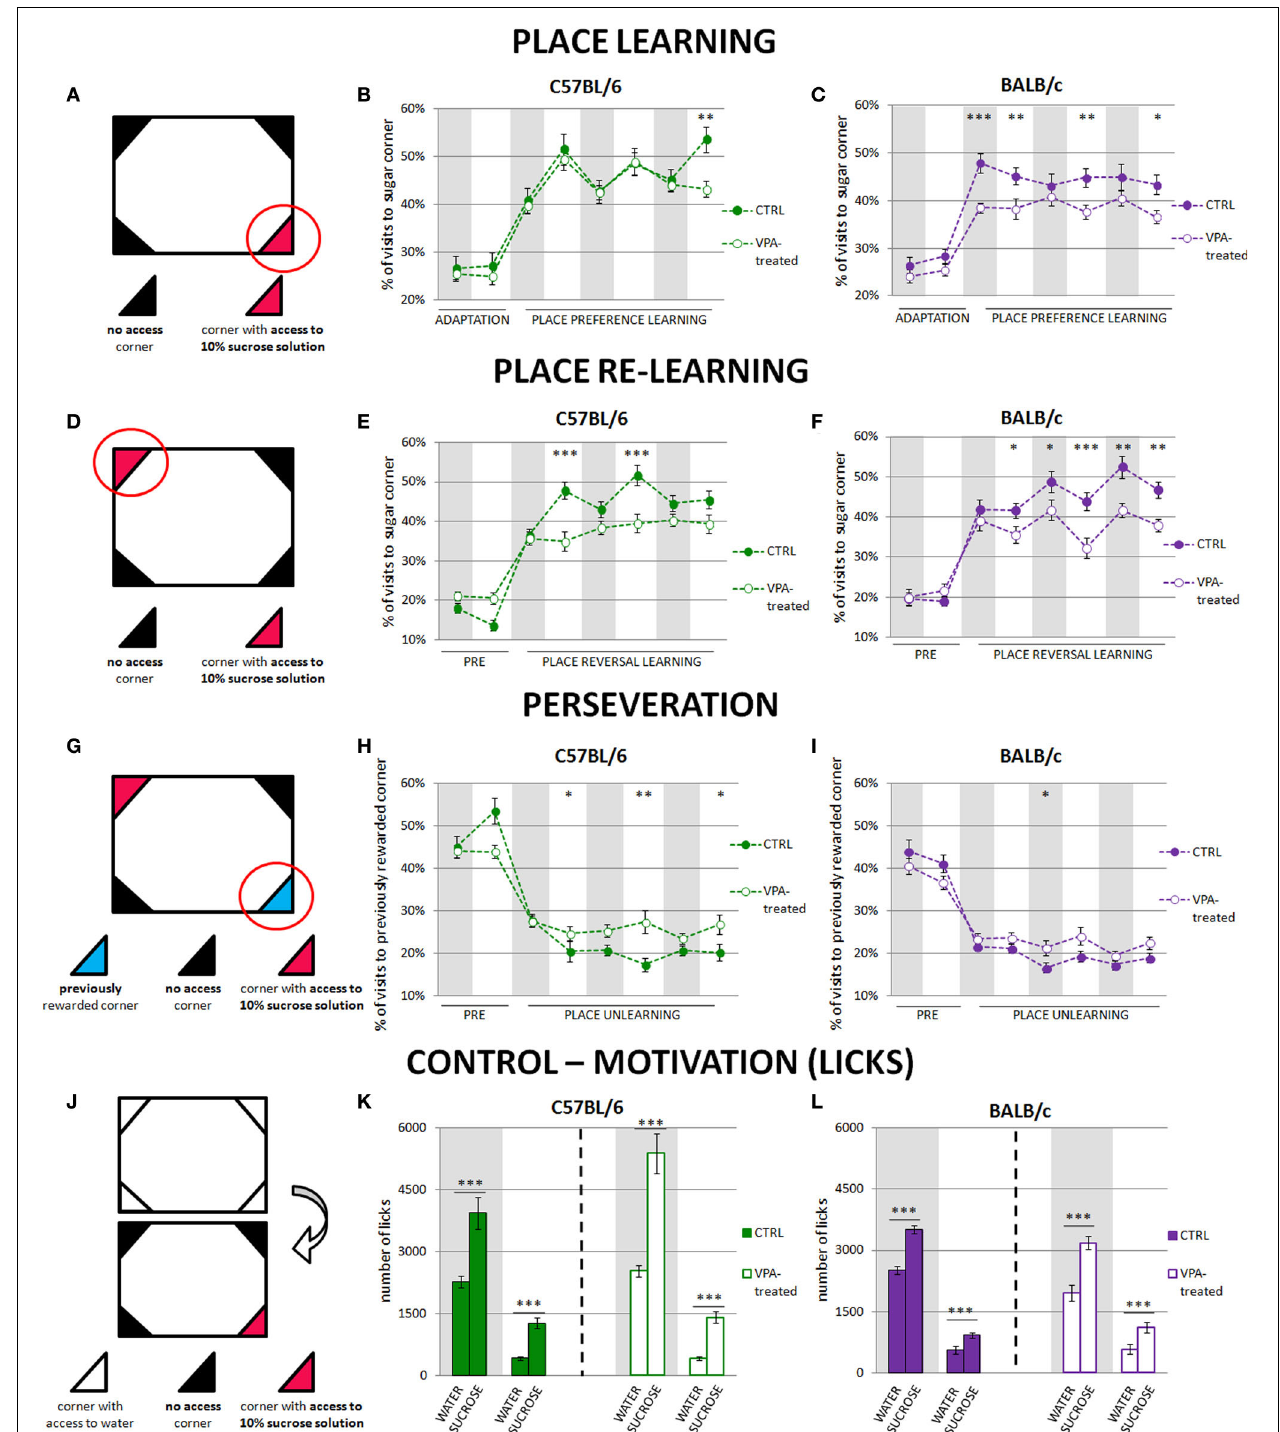
FIGURE 1 | Impairment of reward motivated place learning is much stronger in valproate-treated BALB/c than C57BL/6 mice. Place learning deficits in valproate-treated C57BL/6 mice are related to perseverative behaviors. The graphs show percentage of correct visits (in the corner with sweetened water). The results are presented separately for the day and night phases, and gray shaded areas represent the periods of the experiment when